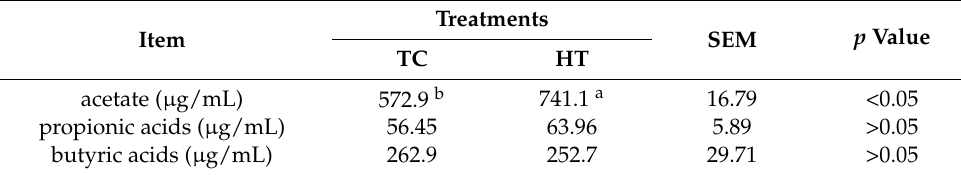
Table 4. Effects of thermal environment on the content of SCFAs in the